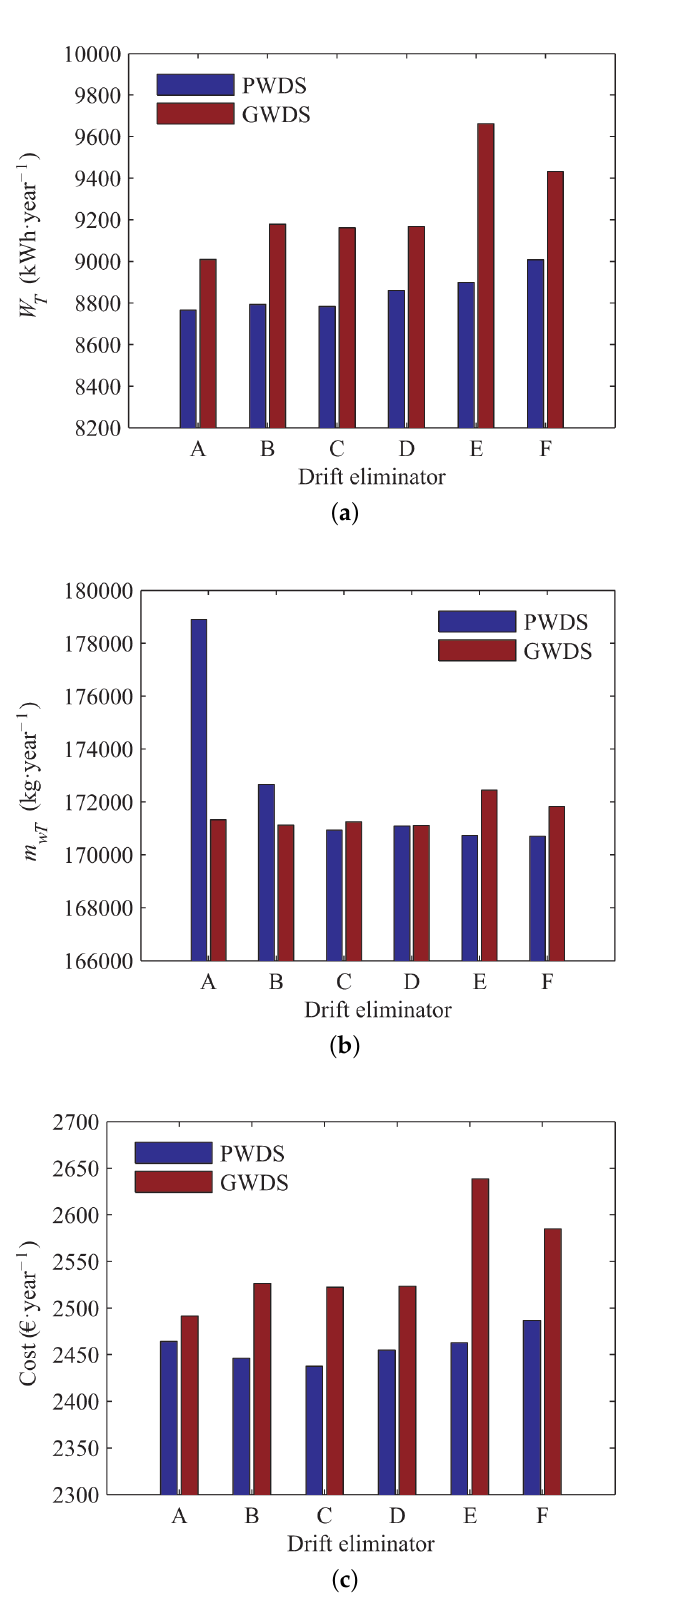
Figure 12. Energy consumption ( a ), water loss ( b ) and cost ( c ) for each configuration using